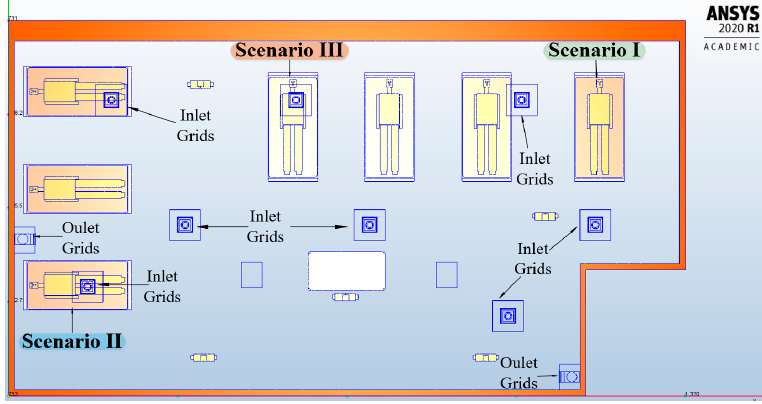
Figure 4. The three scenarios for the HVAC system, according to the location of the patients in the intensive care unit. Table 1. The boundary conditions used for computational fluid dynamics (CFD)-finite element method (FEM) simulations.